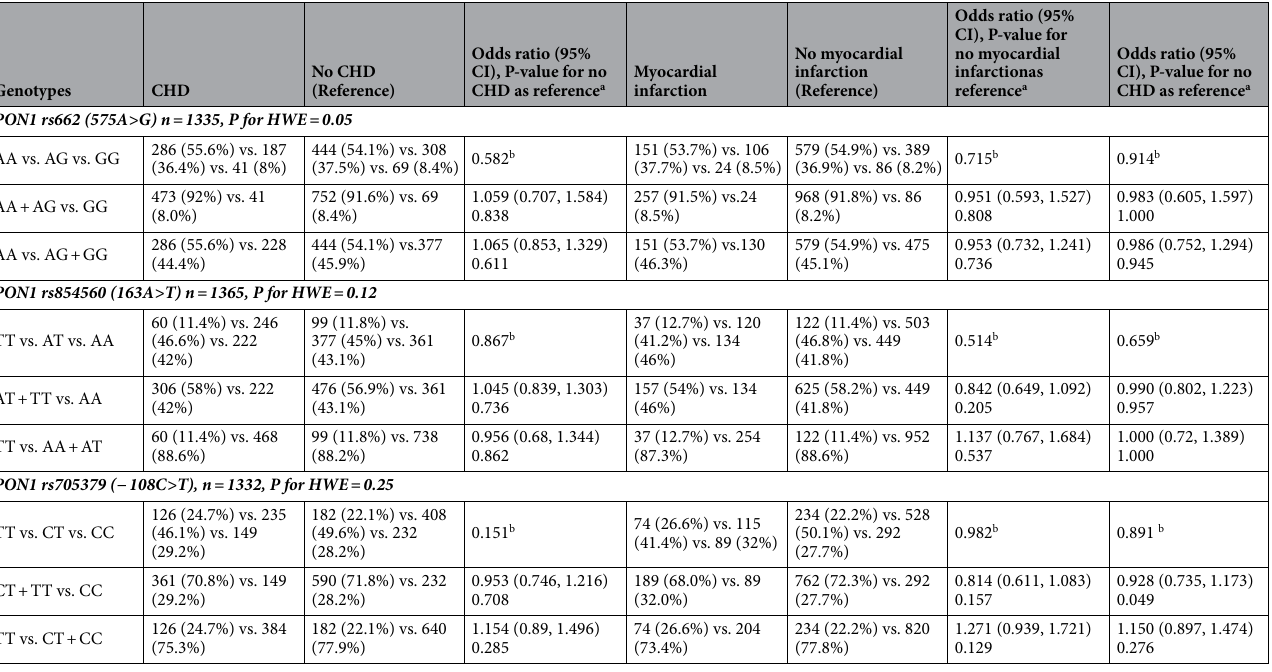
Table 4. PON1 polymorphic variants and prevalence of coronary heart disease and type 1 myocardial infarction in HD patients. CHD coronary heart disease, HD haemodialysis, PON1 —paraoxonase 1 gene. a Fisher’s exact test. b Cochran-Armitage test.